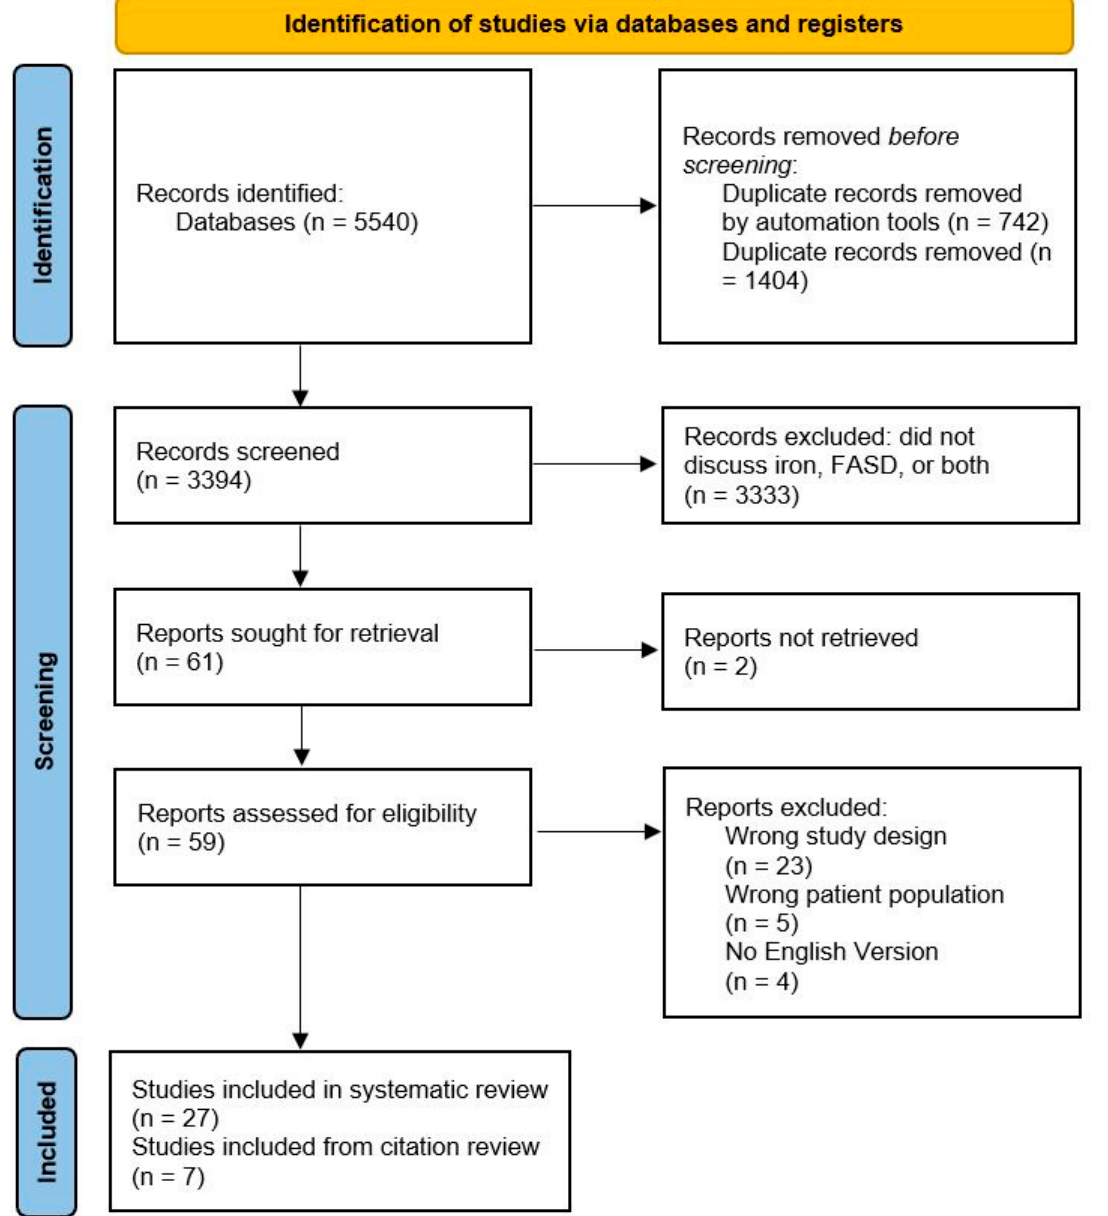
Figure 2. PRISMA flowchart for scoping review. Table 1. Scoping review results by category.